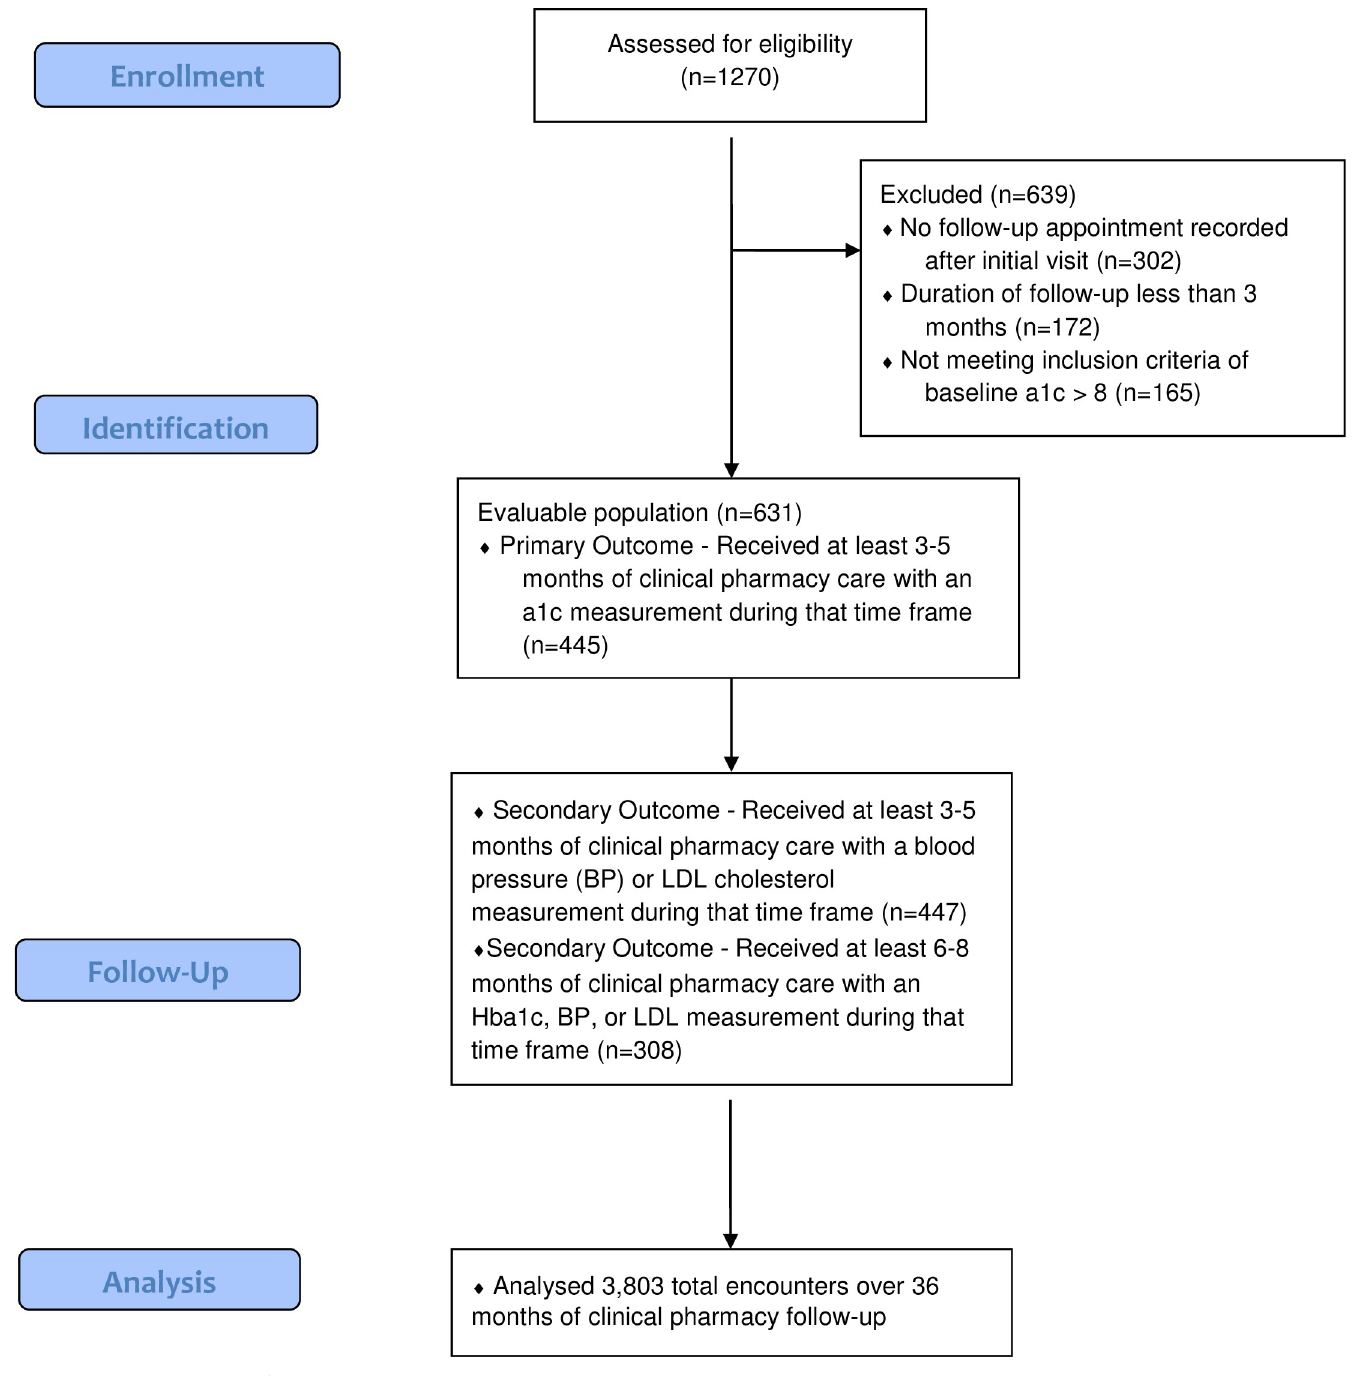
Fig 1. Study diagram. Patient